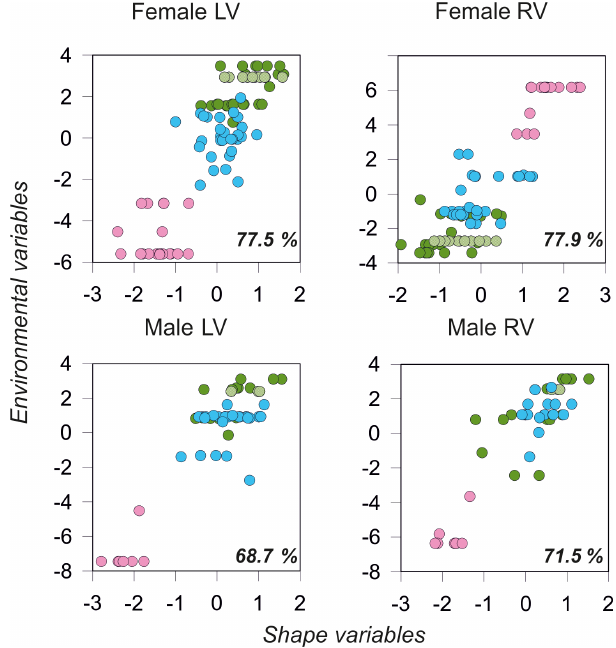
Figure 4. First axis of the PLS analysis of carapace shape and en- vironmental variables. Colours refer to the different regions (blue – Florida, green – Mexico, light green – Lake Punta Laguna, pink –